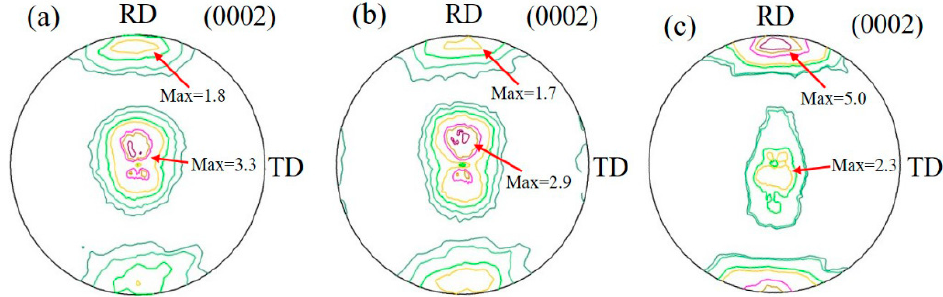
Figure 4. Pole figures (0002) of the ECAR-CB AZ31 Mg alloy samples prepared at different final rolling temperatures: ( a ) 350 °C, ( b ) 450 °C and ( c ) 550 °C.